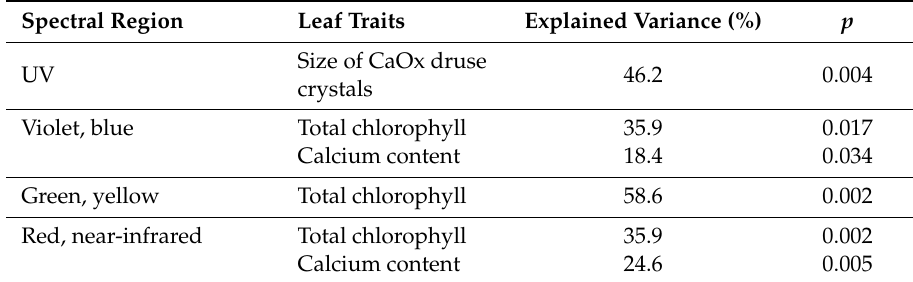
Table 3. Explained variance of the reflectance in di ff erent spectral regions for the buckwheat leaf surface defined by leaf traits, as obtained by redundancy